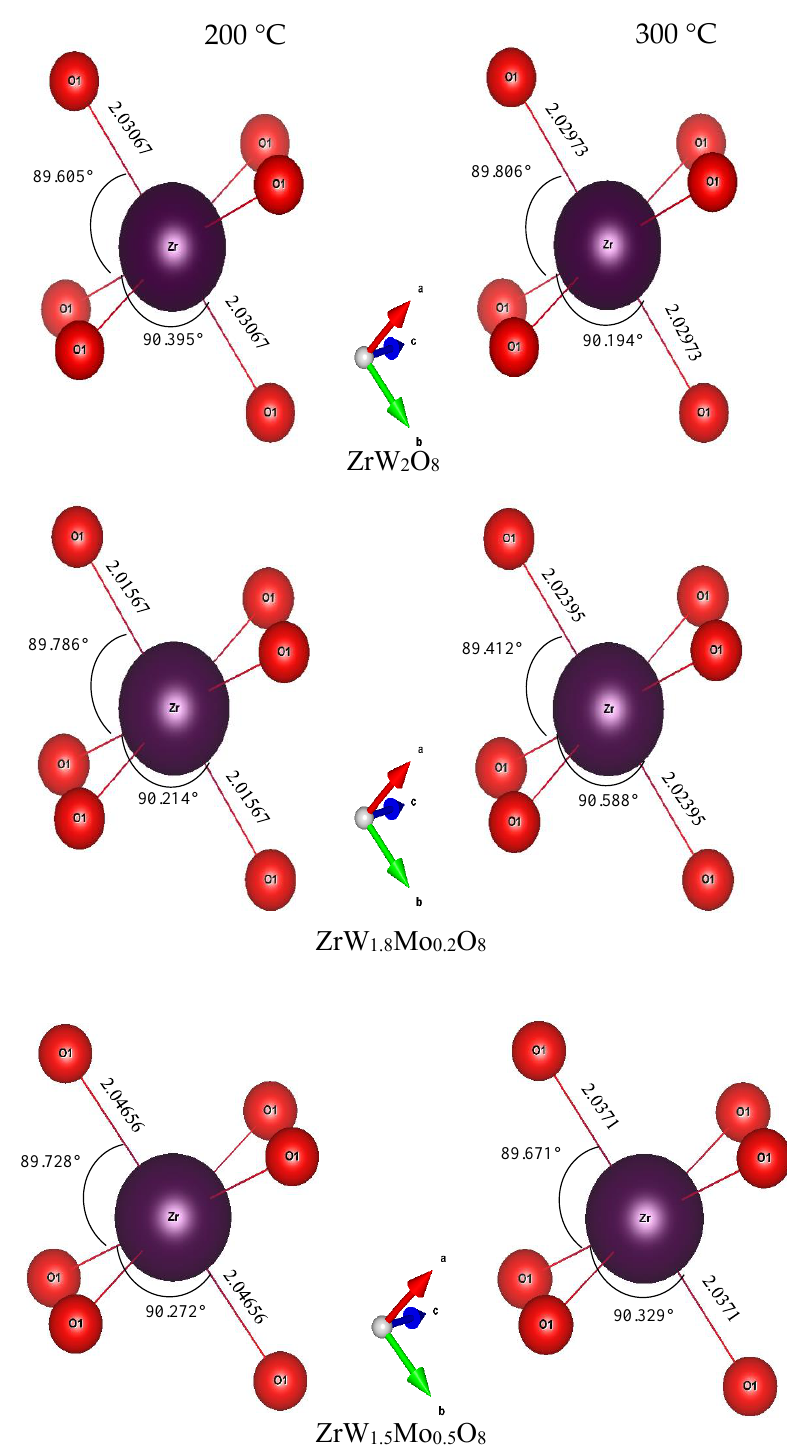
Figure 10. Bond lengths and bond angles of ZrO 6 octahedron in ZrW 2 − x Mo x O 8 compounds.